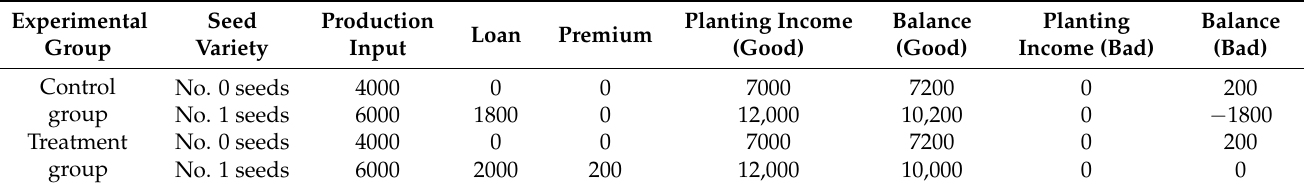
Table A5. Experimental parameter settings comparison of traditional and innovative seeds (Unit: Yuan).